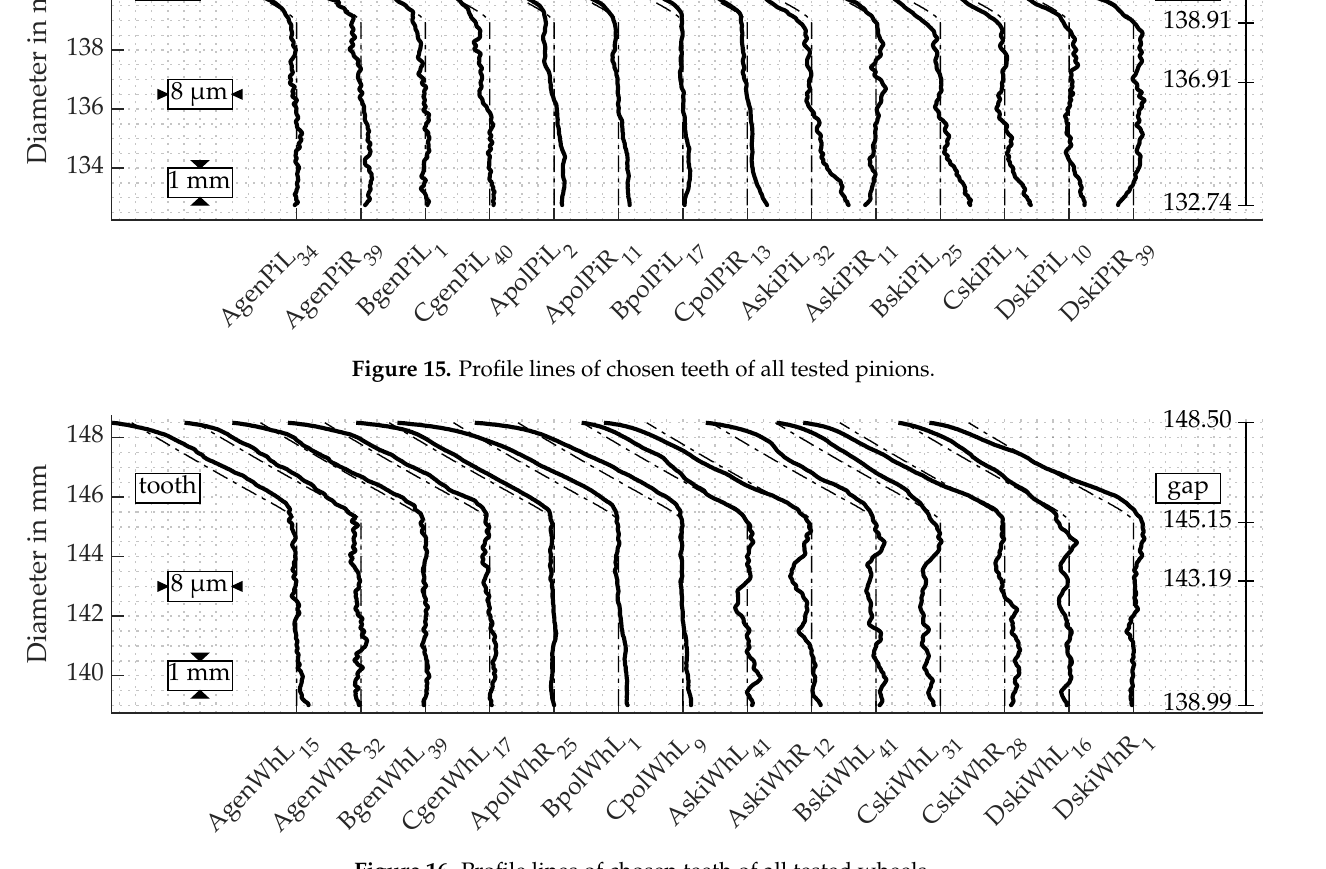
Figure 16. Profile lines of chosen teeth of all tested